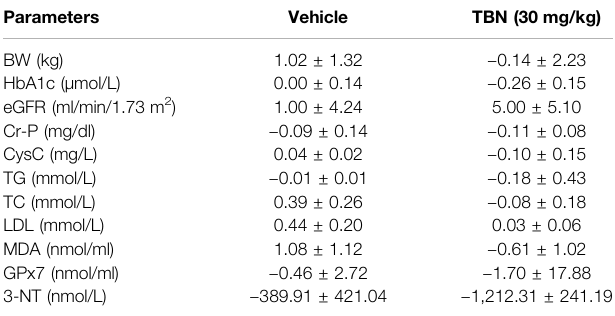
TABLE 1 | TBN prevents the progression of DKD in rhesus macaques. Parameters